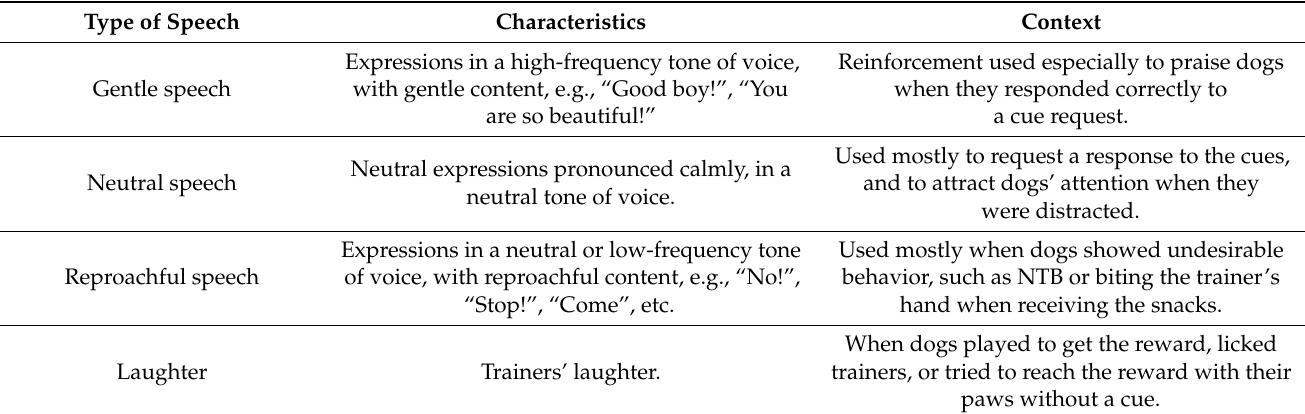
Table 2. Characterization of the vocal behaviors exhibited by trainers with dogs during training sessions, and most frequent contexts of use. Type of Speech